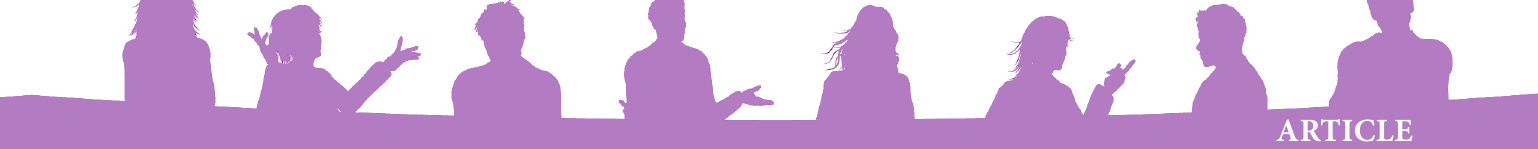
64%) than in the abstinent users group ( n =14, 33%) having legal